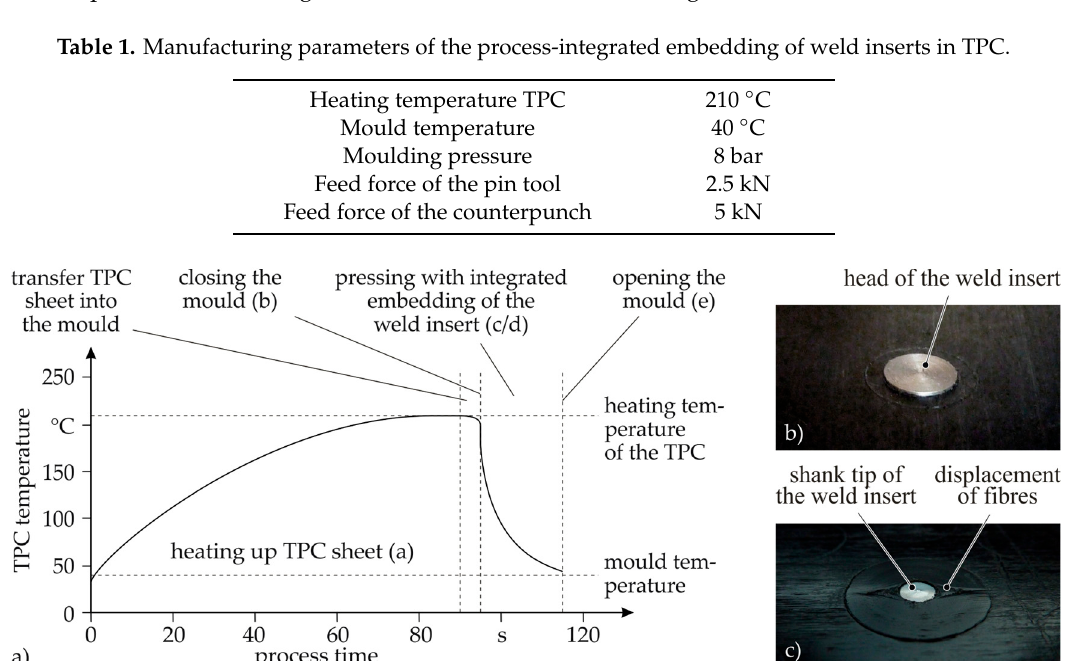
Figure 2. Schematic illustration of the temperature curve during process-integrated embedding of weld inserts in TPC with associated process steps from Figure 1. ( a ), TPC test specimen with integrated weld insert type A: top view ( b ) and bottom view ( c ).